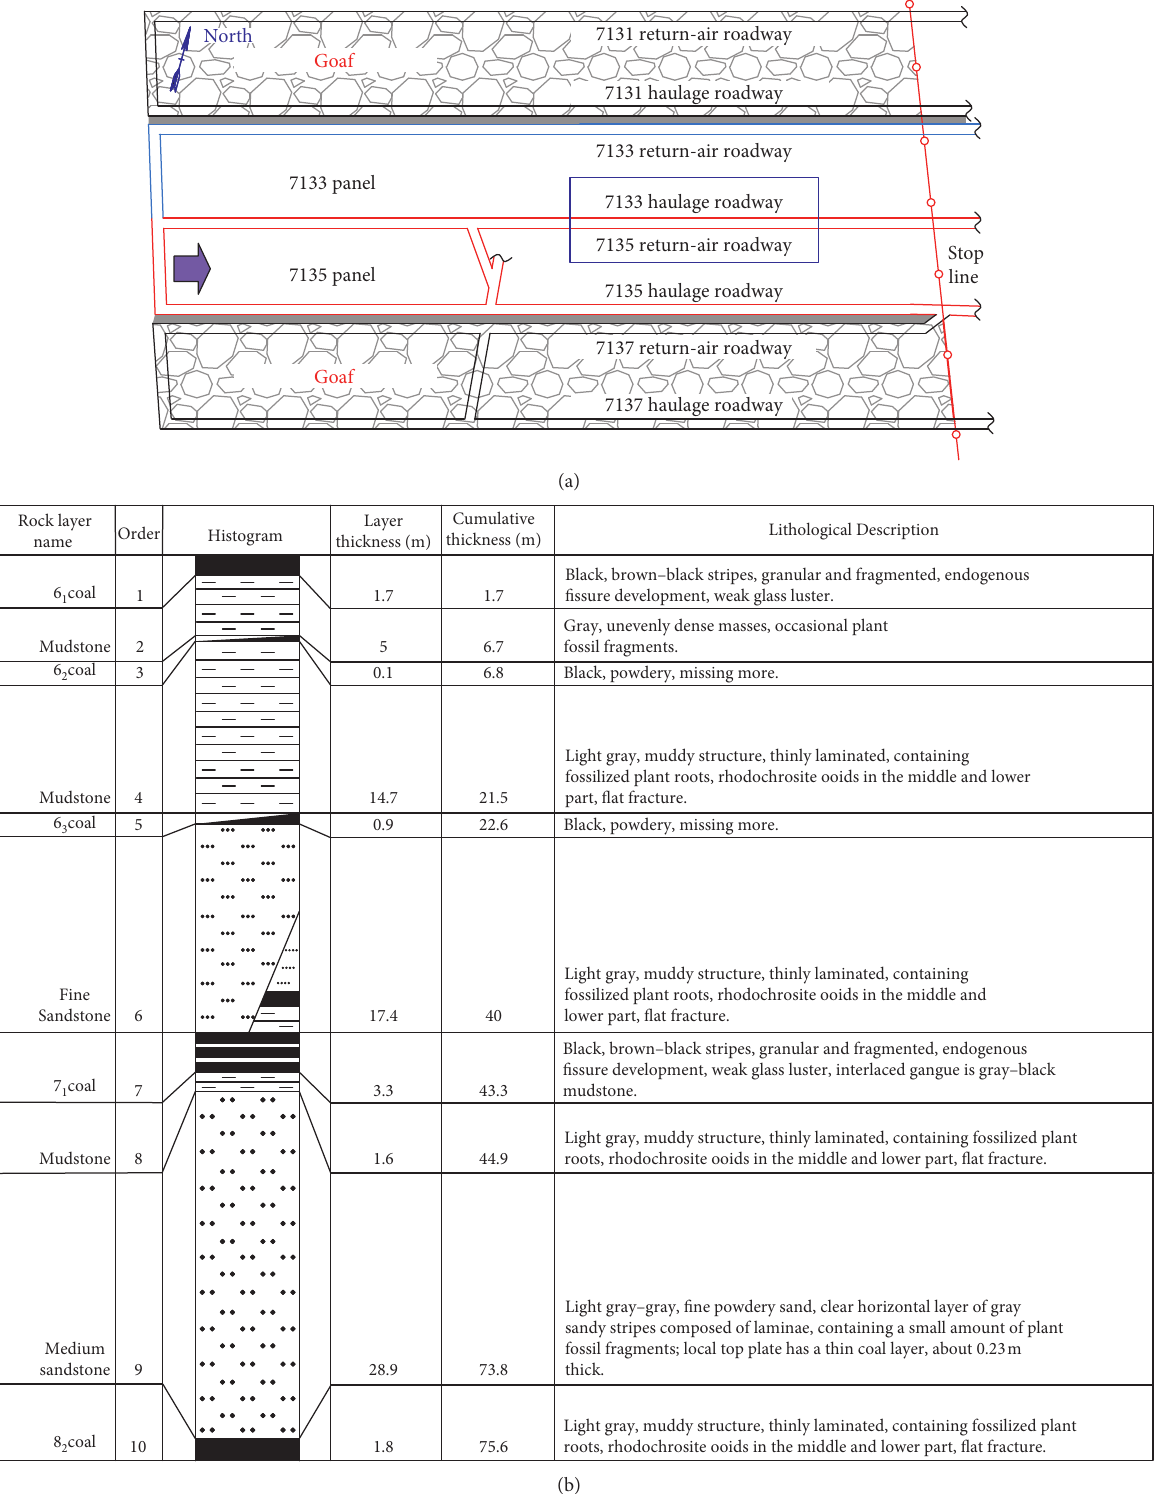
Figure 1: View of gob-side entry retaining and stratigraphic column. (a) View of 7135 full mechanized coal face. (b) Comprehensive stratigraphic